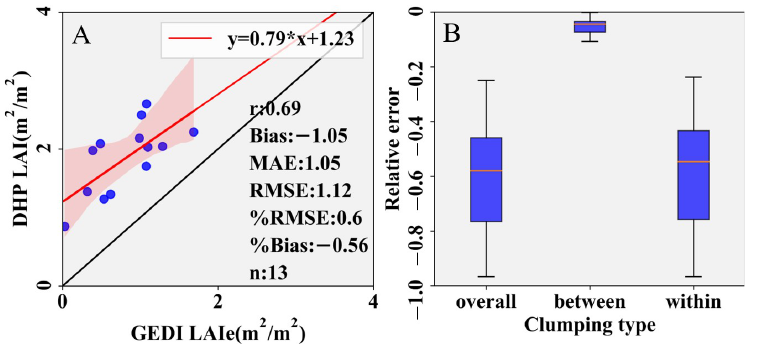
Figure 8. The influence ( A ) and relative errors ( B ) of the clumping effect. The black and red solid lines in ( A ) are the 1:1 line and regression line, respectively. The relative error is caused by clumping in different scales, such as footprint (overall), between crowns (between), and within crowns